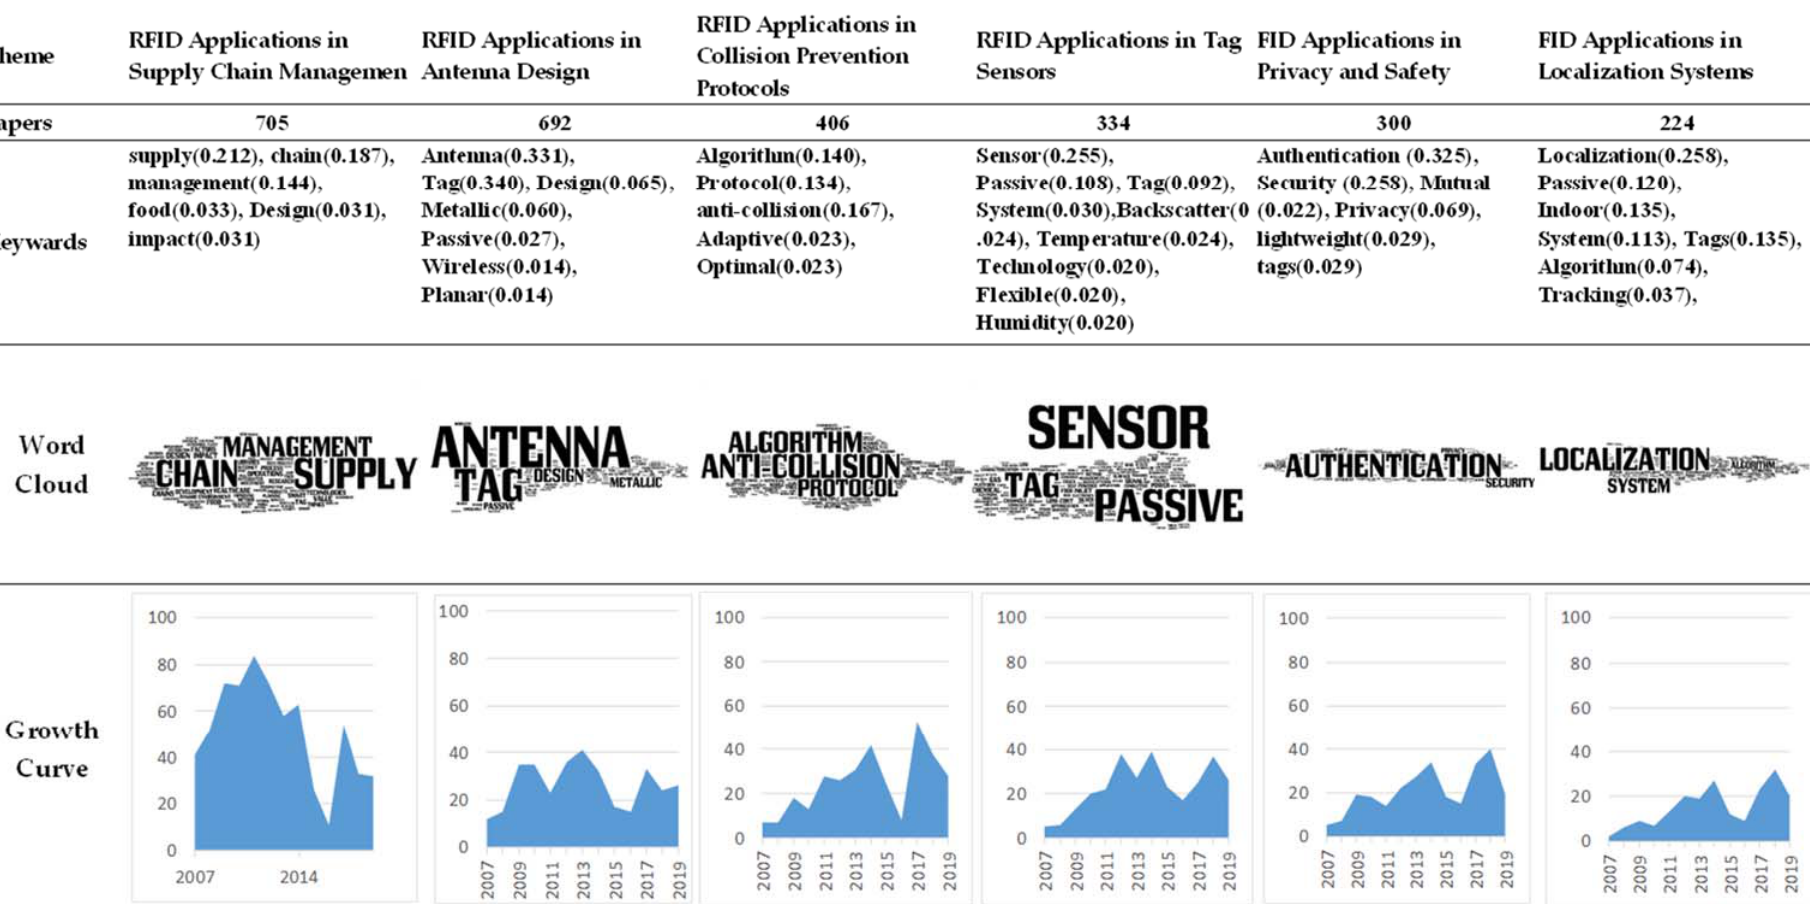
Figure 7. Themes, number of papers, keywords, word cloud and growth curve of each group.